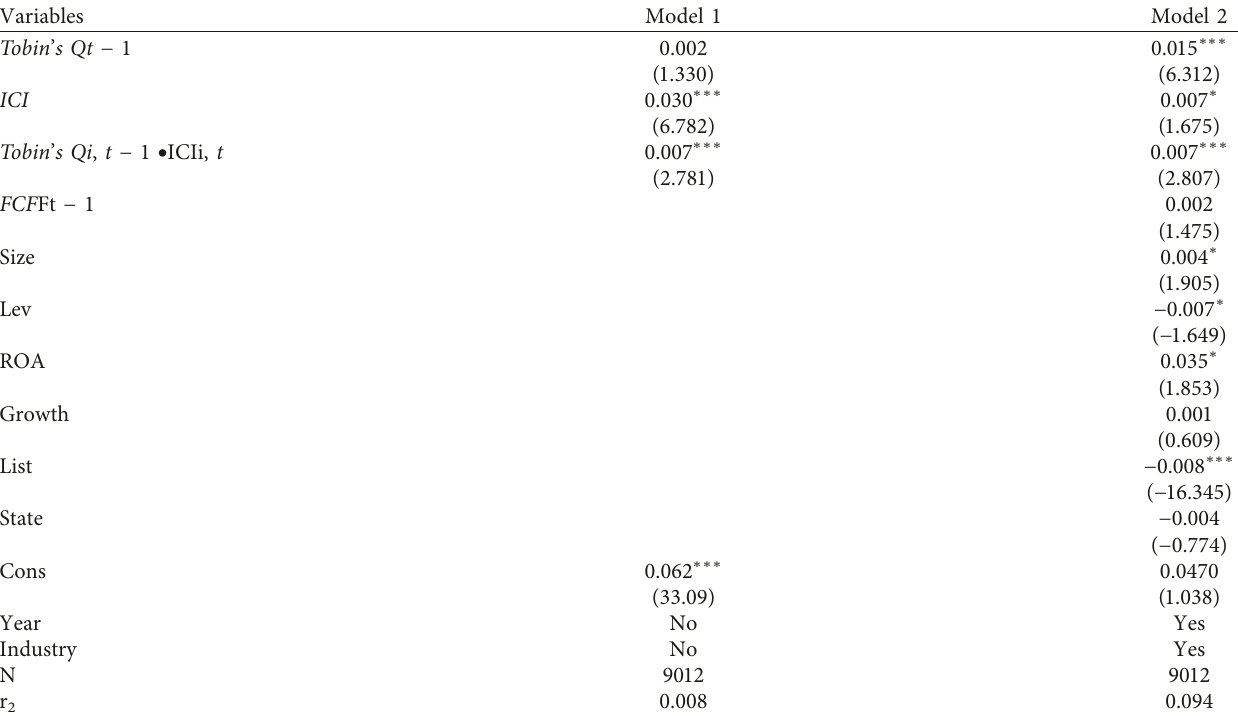
Table 4: Regression analysis of internal control quality and capital allocation